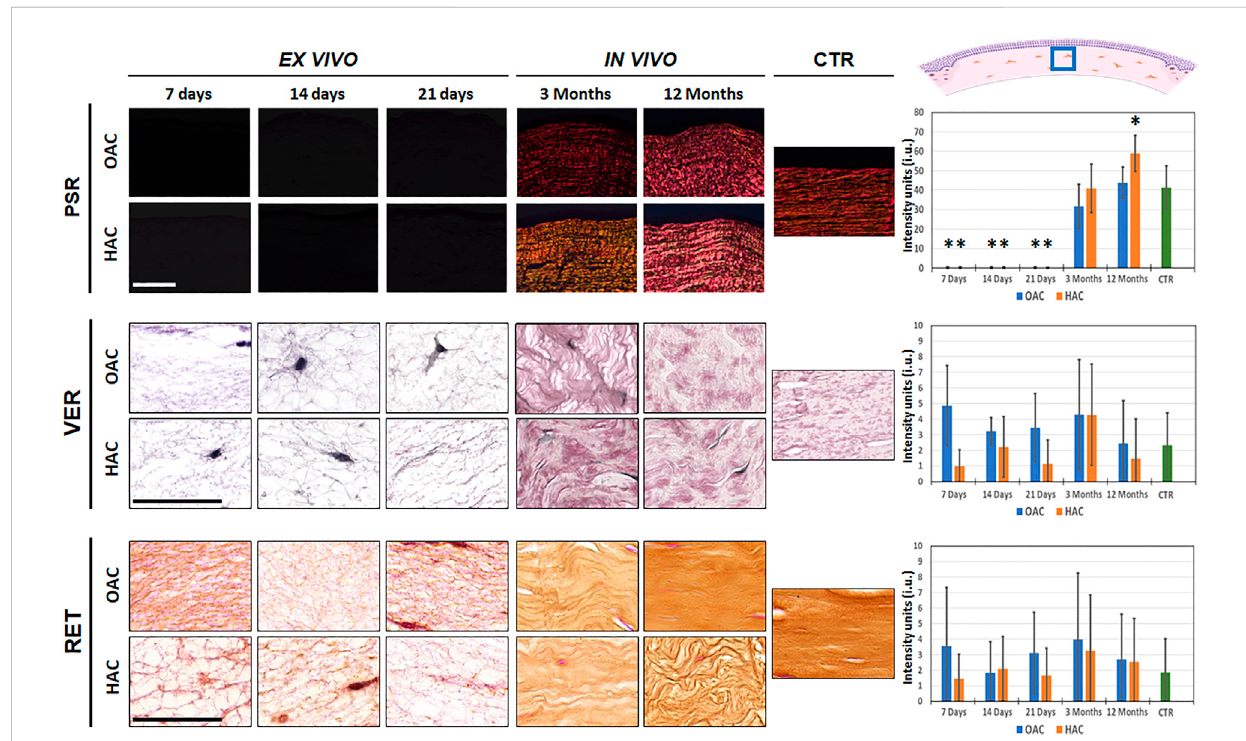
FIGURE 3 Identi fi cation of fi brillar components of the corneal stroma of orthotypical (OAC) and heterotypical (HAC) arti fi cial corneas and controls. PSR: picrosirius red histochemistry for collagen fi bers detection; VER: Verhoeff histochemistry for elastic fi bers; RET: Gomori ’ s reticulin histochemistry for reticular fi bers. The area in which the in vivo histological images were obtained is labeled with a blue square in the illustration representing the rabbit cornea shown at the upper right corner. Bioarti fi cial corneas kept ex vivo for 7, 14 and 21 days, and corneas grafted in vivo for 3 and 12 months are shown. Controls (CTR) correspond to native, normal human corneas. Scale bars: 50 µm (applicable to all images). Histograms to the right correspond to the quantitative analysis of signal intensity quanti fi ed in intensity units (i.u.) of the ImageJ software. Asterisks represent statistically signi fi cant differences as compared to CTR